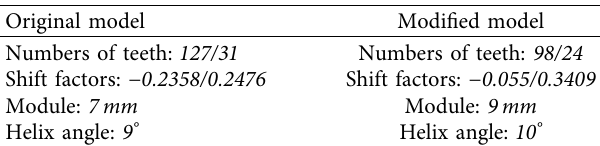
Table 5: Original eigenfrequencies (segmental). Table 6: Parameter comparisons between modified and original helical